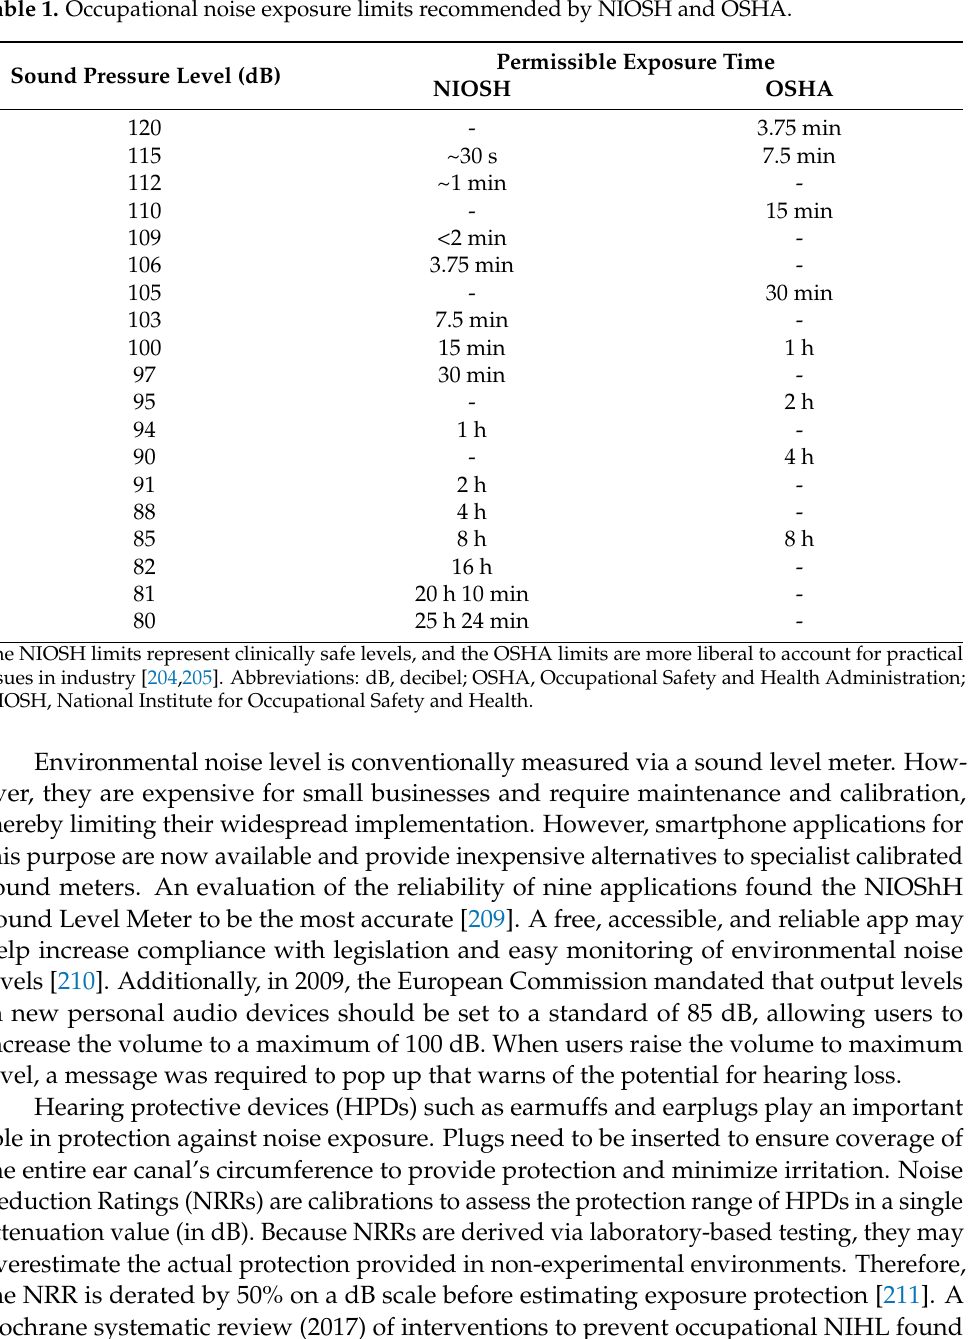
Permissible Exposure Time